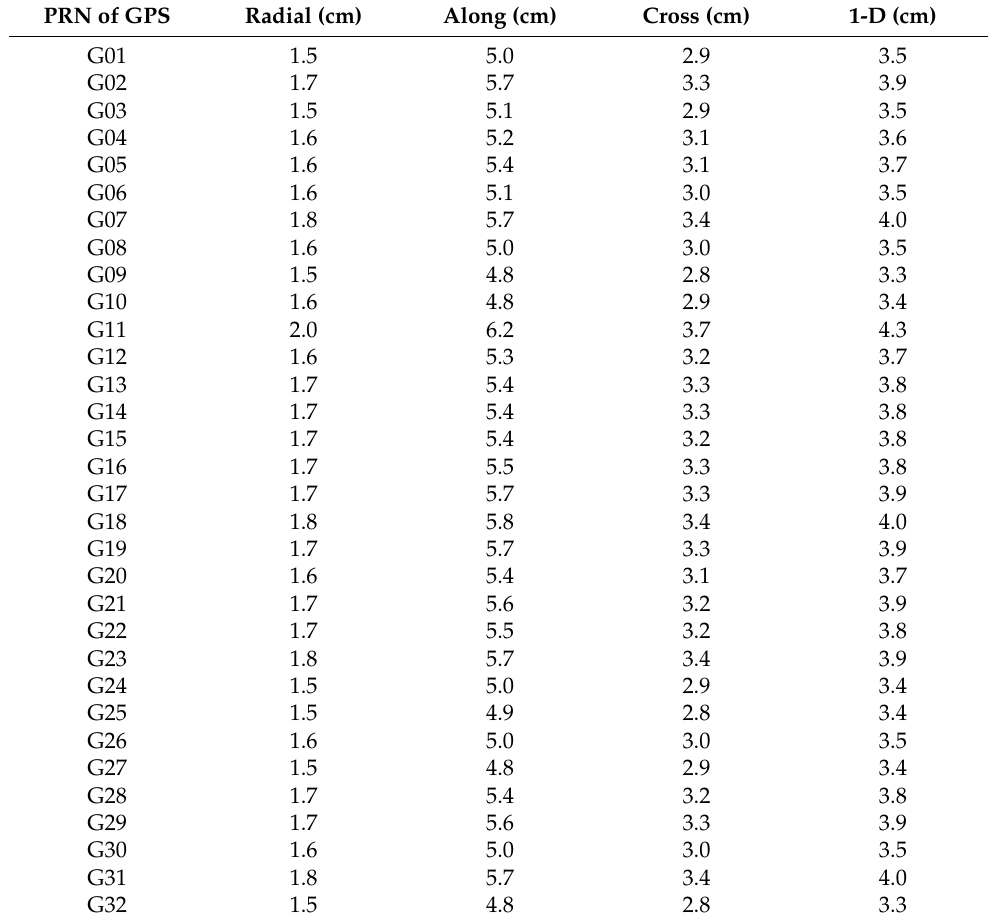
Figure 8. Mean RMS in the RAC components and 1-D of QZSS NONE GEO satellites in comparison with GFZ final orbit. Table 4. Mean RMS value of GPS satellites in comparison with GFZ final orbit. PRN of GPS Radial (cm) Along